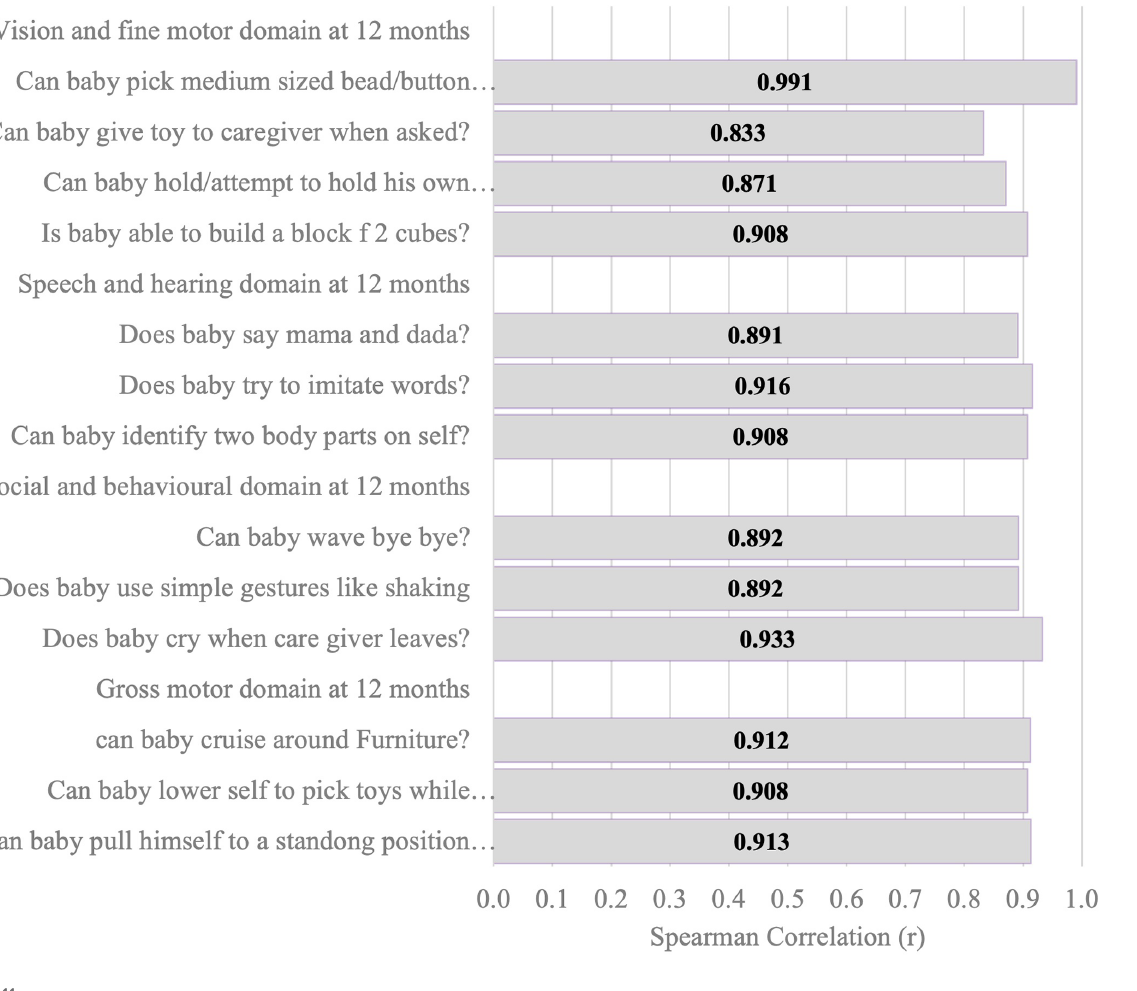
FIGURE 11 Spearman correlation coef fi cient of the ISDS scores of two assessors of the same participants aged 12